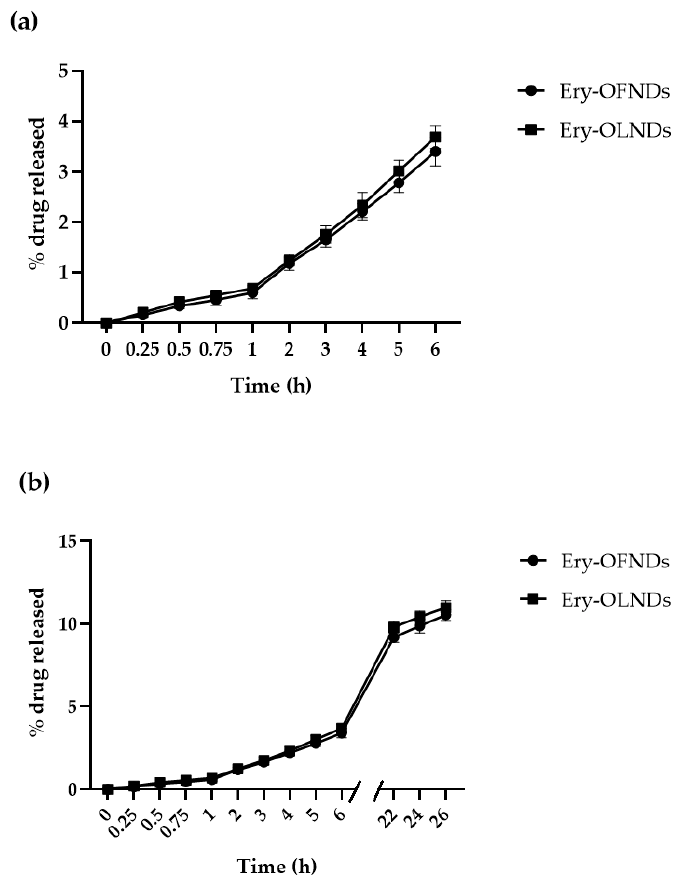
Figure 2. In vitro release kinetics of erythromycin estolate from both the drug-loaded OF and OL nanodroplet formulations: represented as short-term ( a ) and long-term ( b ) percentages of release.